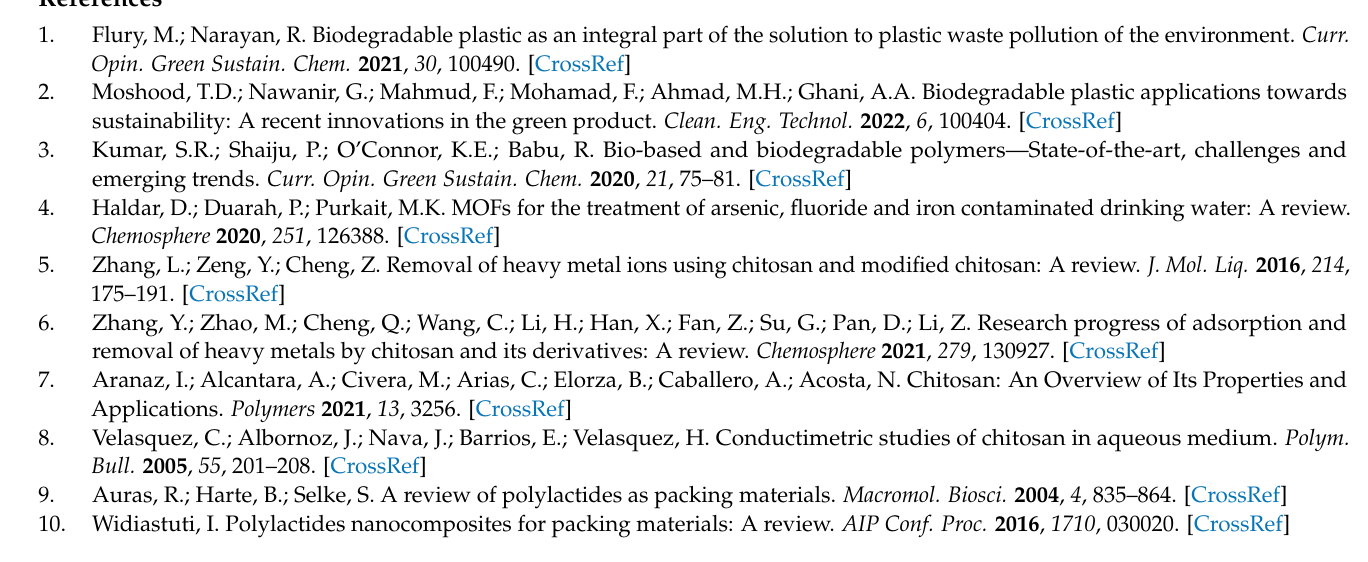
(E); Table S7: Spectral assignment in the range of 1000–800 cm − 1 of the PHB IR spectrum; Figure S8: The range 1250–1000 cm − 1 of the IR spectrum of PLA after UV irradiation (hours): 0 (A), 2 (B), 5 (C), 24, (D), 144 (E); Table S9: Spectral assignment in the range of 1250–1000 cm − 1 of the PLA IR spectrum; Figure S10: The range 1500–1200 cm − 1 of the IR spec-trum of PLA after UV irradiation (hours): 0 (A), 2 (B), 5 (C), 24, (D), 144 (E); Table S11: Spectral assignment in the range of 1500–1200 cm − 1 of the PLA IR spectrum; Figure S12: IR spectrum of PLA after UV irradiation. The range of the vibrational spectrum related to the C=O carbonyl group (1753 cm − 1 [37,38]- the original PLA; bands in the range of 1724 cm − 1 appear as a result of UV irradiation (hours): 0 (A), 2 (B), 5 (C), 24, (D), 144